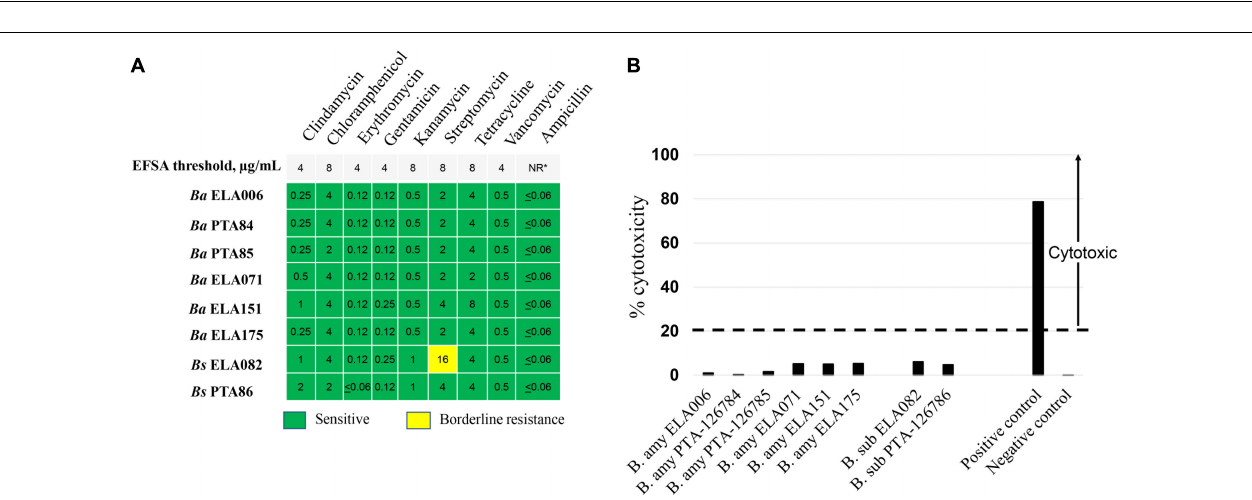
FIGURE 2 | A safety assessment of Bacillus spp. DFM candidates. (A) Antimicrobial susceptibility tests of Bacillus spp. MIC ( µ g/mL) values for each antibiotic tested of respective Bacillus spp. were shown. Nine medically important antibiotics at a concentration range of 0.06–32 µ g/mL were tested and the respective antimicrobial susceptibility cut-off concentrations required for Bacillus spp. were shown at the top panel. (B) Cytotoxicity assessment of Bacillus spp. culture supernatant toward Vero cells. Culture supernatant of B. cereus ATCC 14579 and B. licheniformis ATCC14580 were used as positive and negative controls, respectively. Cytotoxicity level above 20%, dashed line, is considered cytotoxic. *, NR, not required by EFSA guidelines.